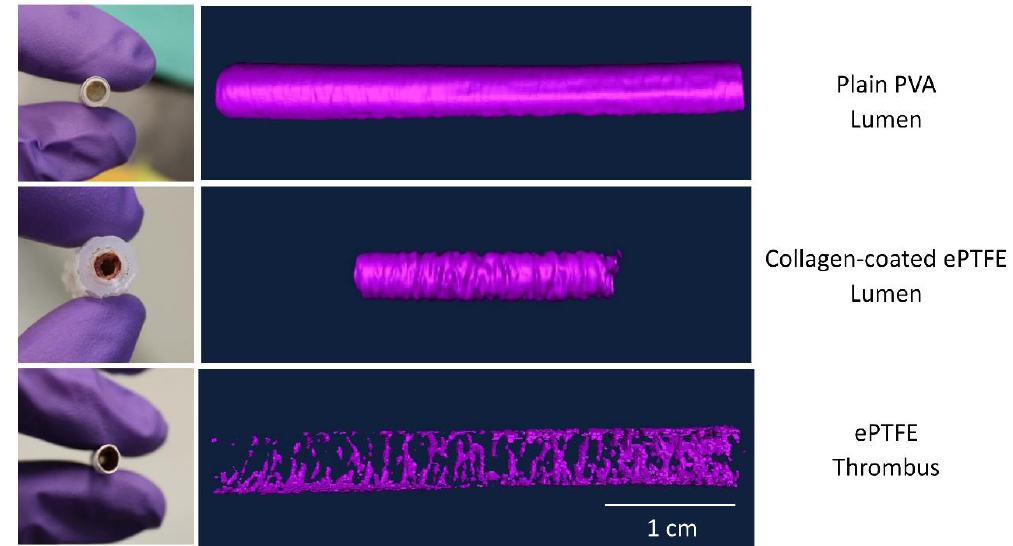
Figure 5. Generation of Amira models from microCT images. All grafts were 4–5 mm inner diameter. PVA and ePTFE samples were 3 or 4 cm in length. Collagen-coated ePTFE samples were 2 cm in length. Scale bar for model images = 1 cm.